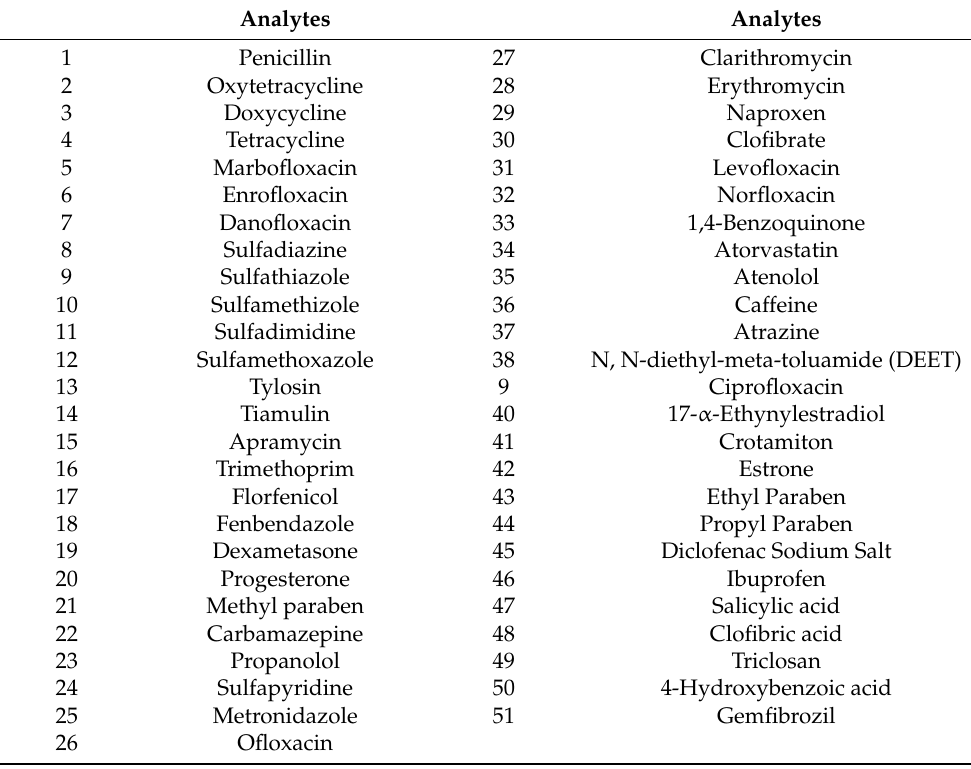
Table 1. List of the 51 contaminants studied from the urban WWTP of the city of Valladolid. Analytes